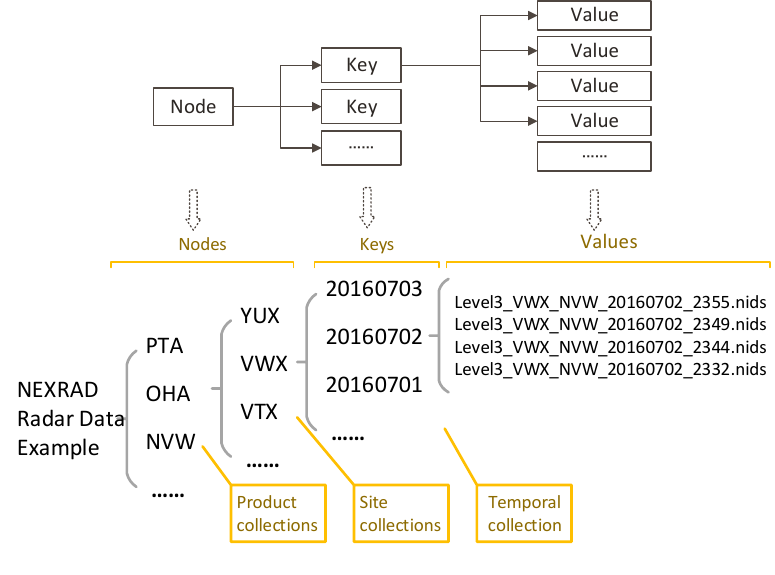
Figure 5. Snapshot file structure.